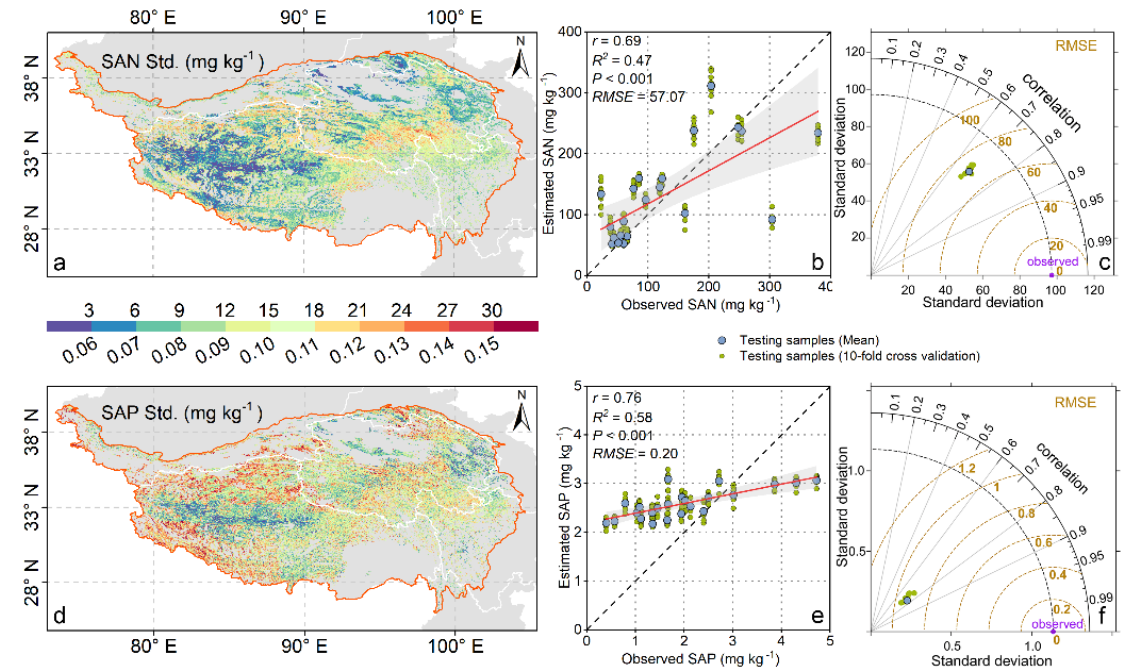
Figure 3. Uncertainties distributions ( a , d ) and RF model testing validation results ( b , c , e , f ) of the SAN and SAP estimates. The dashed black line shows the 1:1 line, the red line shows the performance of the model, and the gray areas indicate the 95% confidence intervals; r, Pearson correlation coefficient; R 2 , coefficient of determination; RMSE, root mean square error.